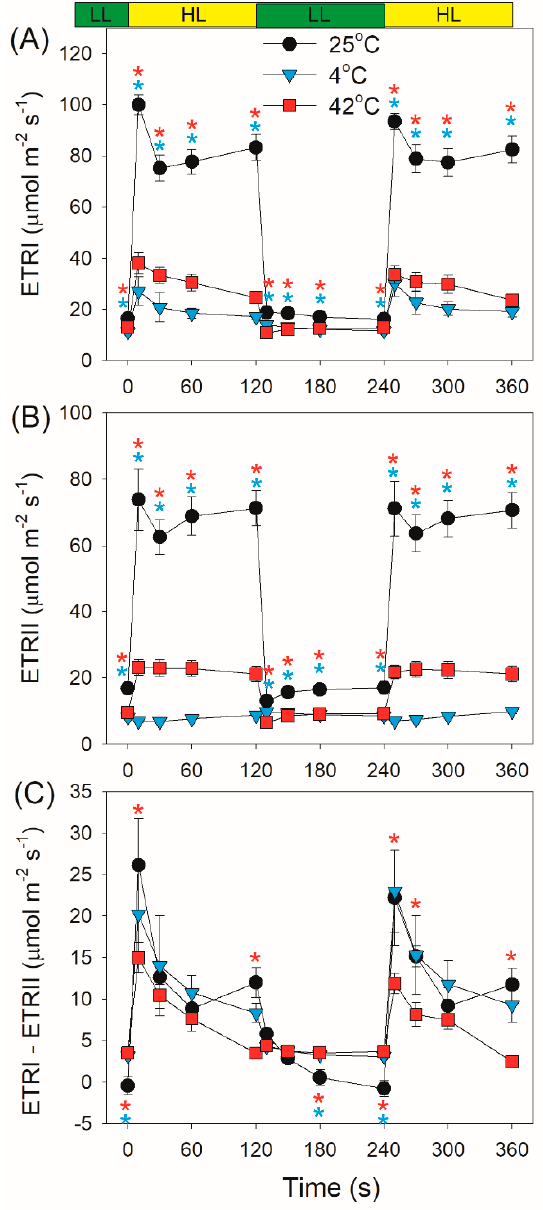
Figure 6. Changes in ETRI ( A ), ETRII ( B ) and ETRI–RTRII ( C ) after transition from 59 to 1455 µ mol photons m − 2 s − 1 at 25 °C, 4 °C, and 42 °C. Values are means ± SE ( n = 5). Red asterisks indicate significant differences between 25 °C and 42 °C, and blue asterisks indicate significant differences between 25 °C and 4 °C.